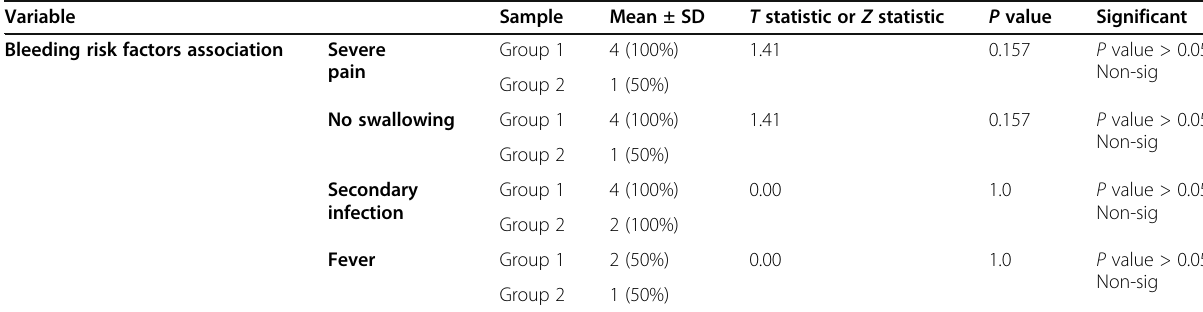
Table 8 The distribution of risk factors of hemorrhage post-operatively Variable